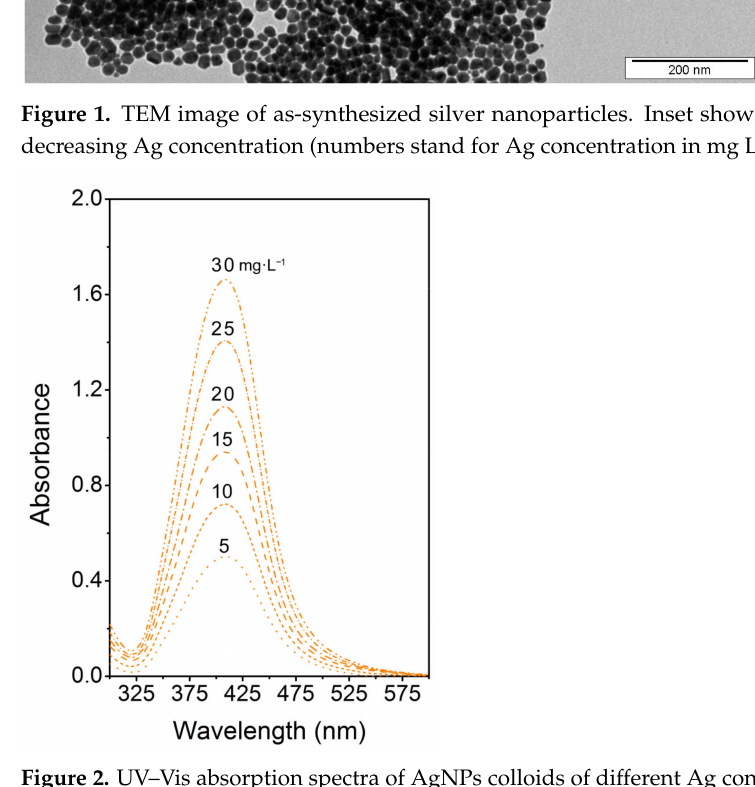
Figure 2. UV–Vis absorption spectra of AgNPs colloids of different Ag